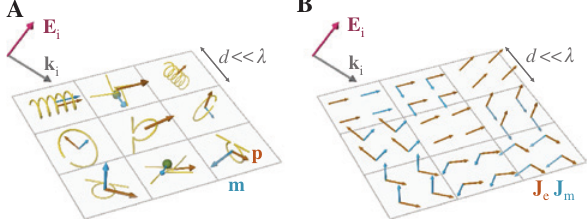
Figure 5: Homogenization of nonuniform